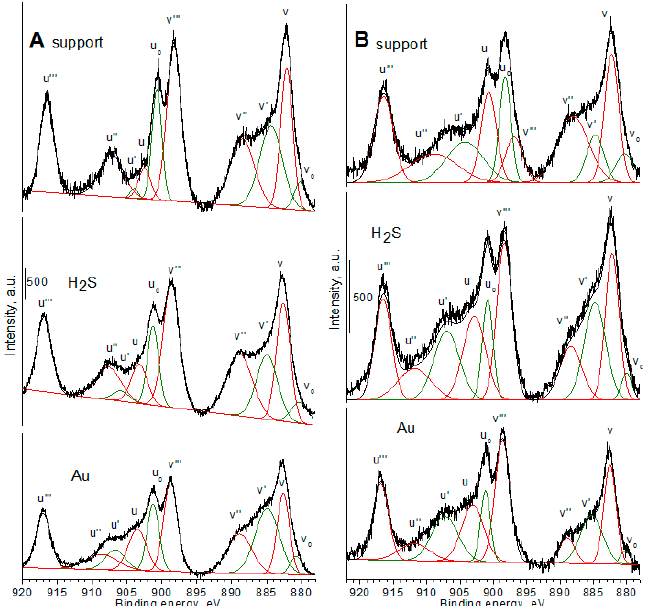
Figure 2. XP spectra recorded for Ce three-dimensional (3d) species for selected oxides before (support) and after modification with sulfur (H 2 S) and gold species (Au). The spectra were recorded for the catalysts based on: ( A ) Ce x Zr y O z (4:1); and, ( B ) Ce x Zr y O z (1:1). The XP spectra of Ce 3+ and Ce 4+ species were marked using green and red line,